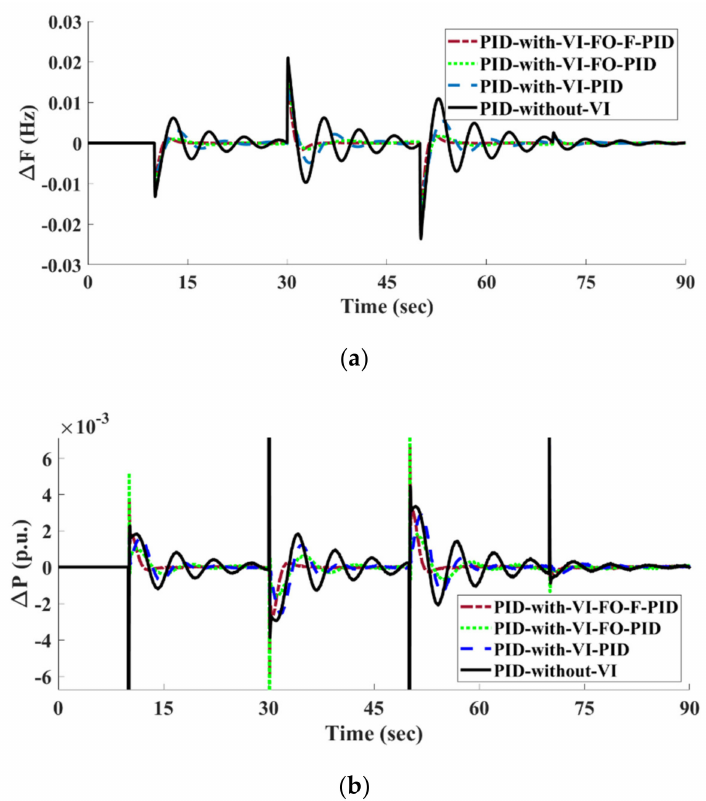
Figure 7. Dynamic response of HPSREG for random load perturbation ( a ) ∆ F ( Hz ) and ( b ) ∆ P ( p . u . )